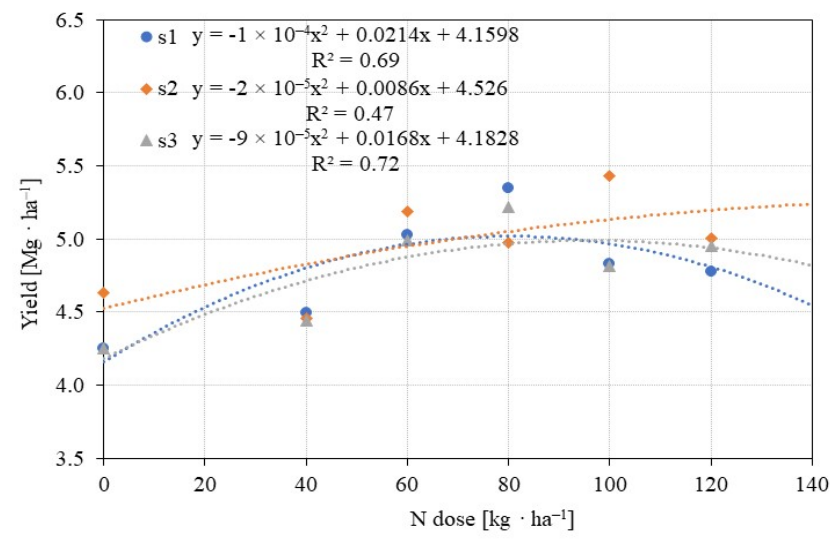
Figure 4. Grain yield of winter wheat genotypes depending on nitrogen fertilization.